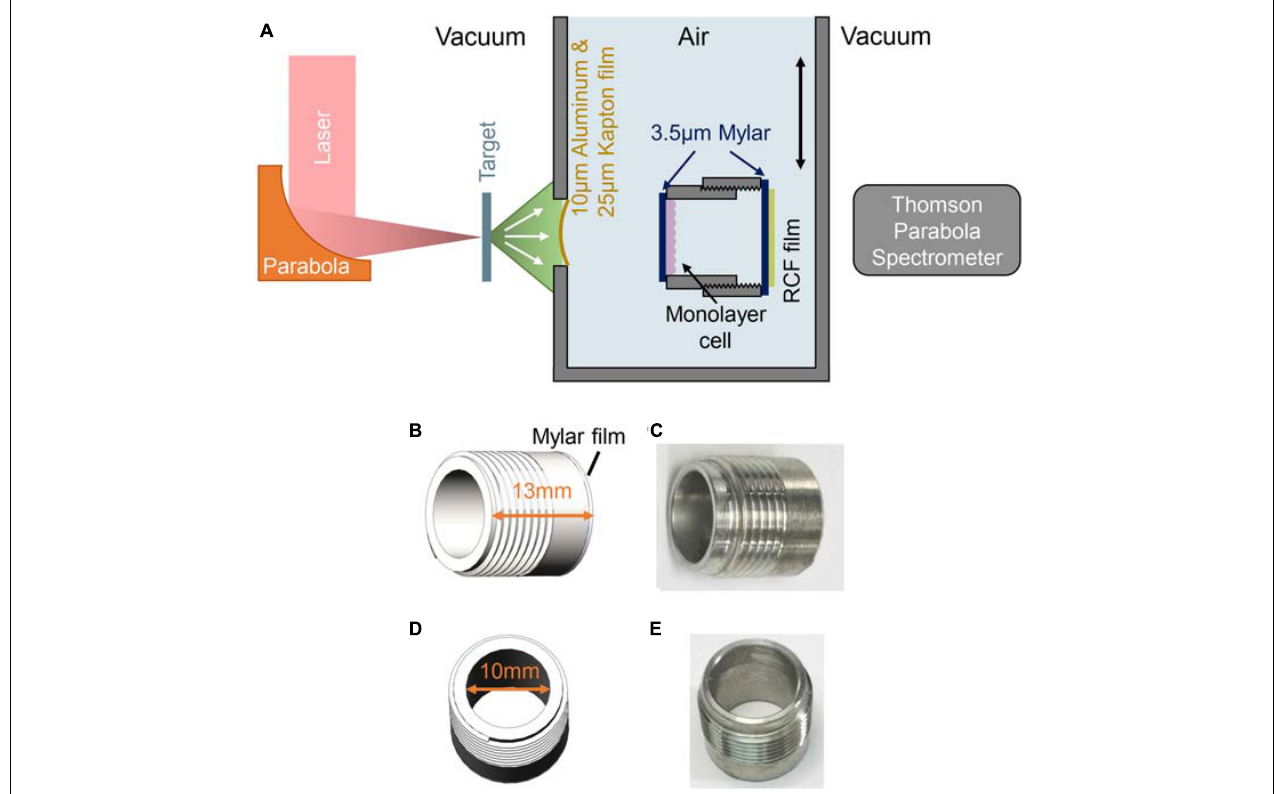
FIGURE 1 | Experimental setup for FLASH irradiation. (A) Schematic drawing of experimental setup. (B,C) Side view of the cell-culture cylinder, cells were cultured on the 3.5 µ m Mylar film adhered to inner side of the cylinder. (D,E) Top view of the cell-culture cylinder.